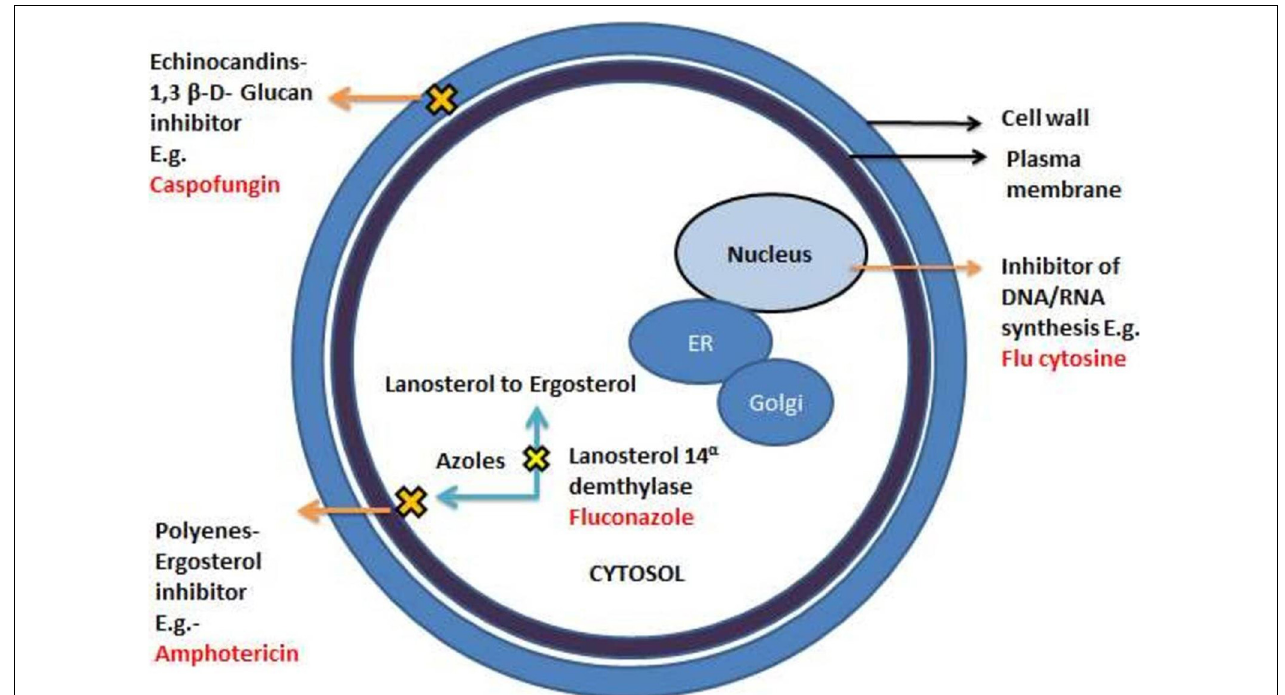
FIGURE 1 | A different mechanism of actions of commonly known antifungal drugs adapted from Spampinato and Leonardi (2013).